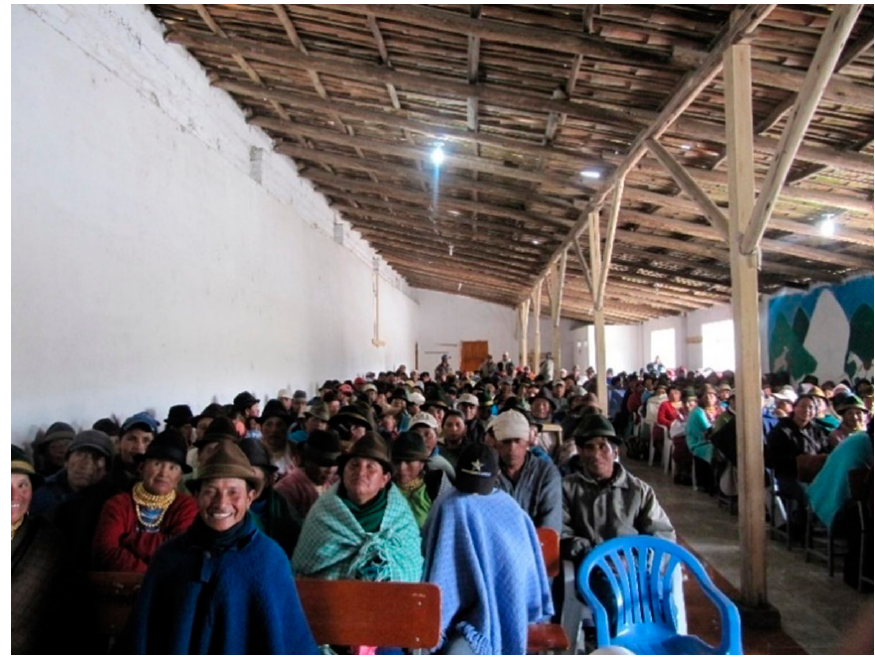
Figure 2. Community assembly at La Chimba.